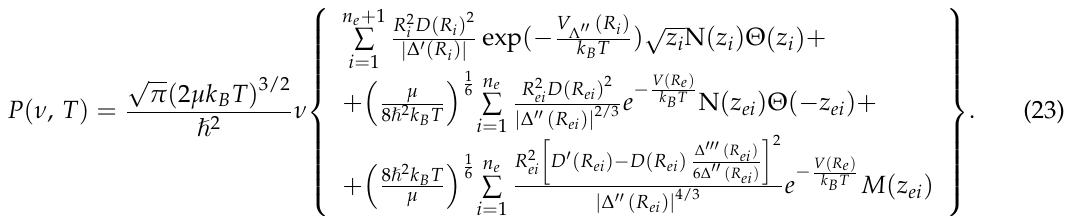
Figure 1. Behavior of functions N ( z ) , M ( z ) , 1 √ H ( z )) ζ